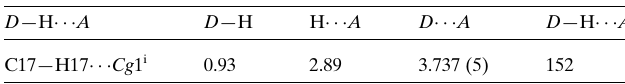
Table 1 Hydrogen-bond geometry (A˚ , (cid:2)